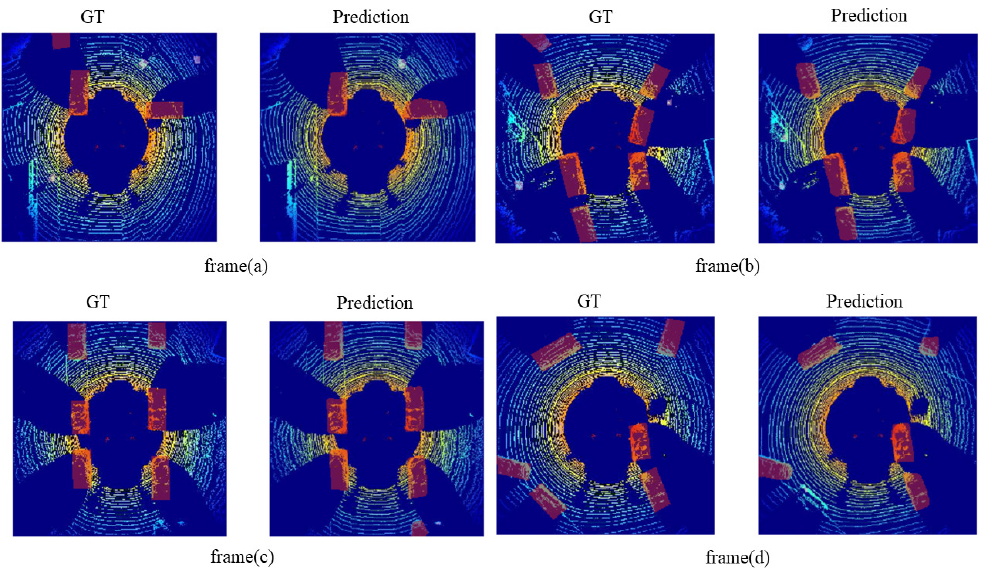
Figure 7. The visualization results on KITTI dataset using our proposed method. Subfigures ( a – d ) shows the ground truth on the right-hand side, and the left-hand side shows the output results. The images shows that the proposed model performs well in different